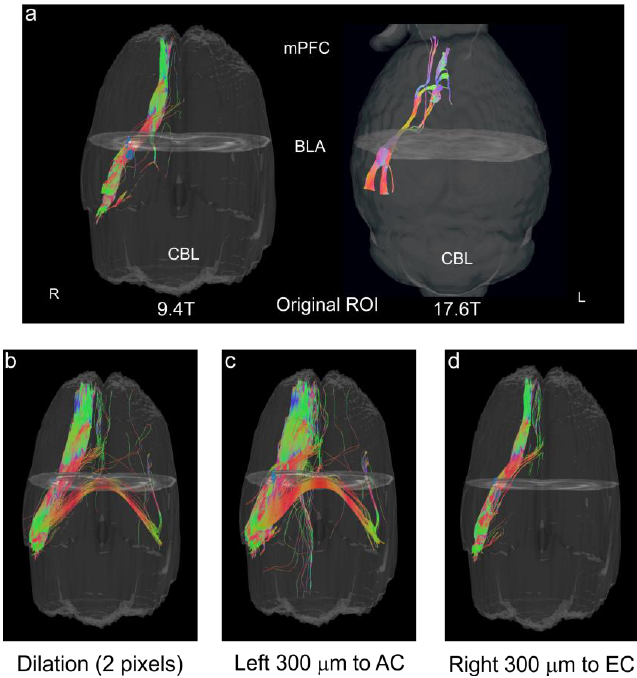
Figure 8 . Tractography validation of the BLA regions from DTI. The BLA regions derived from high CNR directions were evaluated using tractography to evaluate known reciprocal connections be- tween the medial prefrontal cortex (mPFC) and the BLA. ( a ) Tracts (streamlines) from the BLA re- gions delineated on DTI direction 8 (high right CNR; see Figure 3e), illustrate a uniform and com- pact connection between the mPFC and the BLA (left panel). In the right panel using an identical protocol we visualized the enhanced connections of the BLA to the medial prefrontal cortex (mPFC) at 17.6T. ( b ) Uniform dilation by 2 pixels (150μm) of the BLA region resulted in a proliferation of tracts including bilateral projections. ( c ) A leftward shift of BLA region by 300 µm dramatically increased the number of streamlines as well as the appearance of bilateral connections. This shift included portions of the amygdalar capsule. ( d ) An identical rightward shift of 300 µm that now encompassed the smaller external capsule (EC) white matter and potentially portions of the medial amygdala also resulted in increased tract numbers. 4. Discussion The principal findings of the current study are as follows: (1) high resolution DTI, employing specific, directionally encoded vectors, enhances CNR and enables visualiza- tion of the BLA; (2) contrast-to-noise optimization for the right and left amygdala can be accomplished independently; (3) coupled with slice-shifting, the method described here yields high concordance with histological BLA segmentation, allowing for accurate as- sessment of BLA volumes across time; and 4) tractography of BLA projections validated the delineation method. Finally, the principles described here for DTI imaging of the amygdala in the rodent are applicable to other brain regions and across species. We show here that high-field MR diffusion imaging permits resolution and delinea- tion of BLA boundaries in rats. This is important, as volumetric increases or decreases of this structure have been reported in a broad range of rodent models that are used exten- sively to study the physiological importance of the amygdala in health and disease [8,13,14,17]. Electrophysiology experiments as well as neuroanatomical studies can only be performed once, after the animal is dead (postmortem). There is a major need to pro- vide an approach that allows for repeated and detailed evaluation of the BLA, yet there